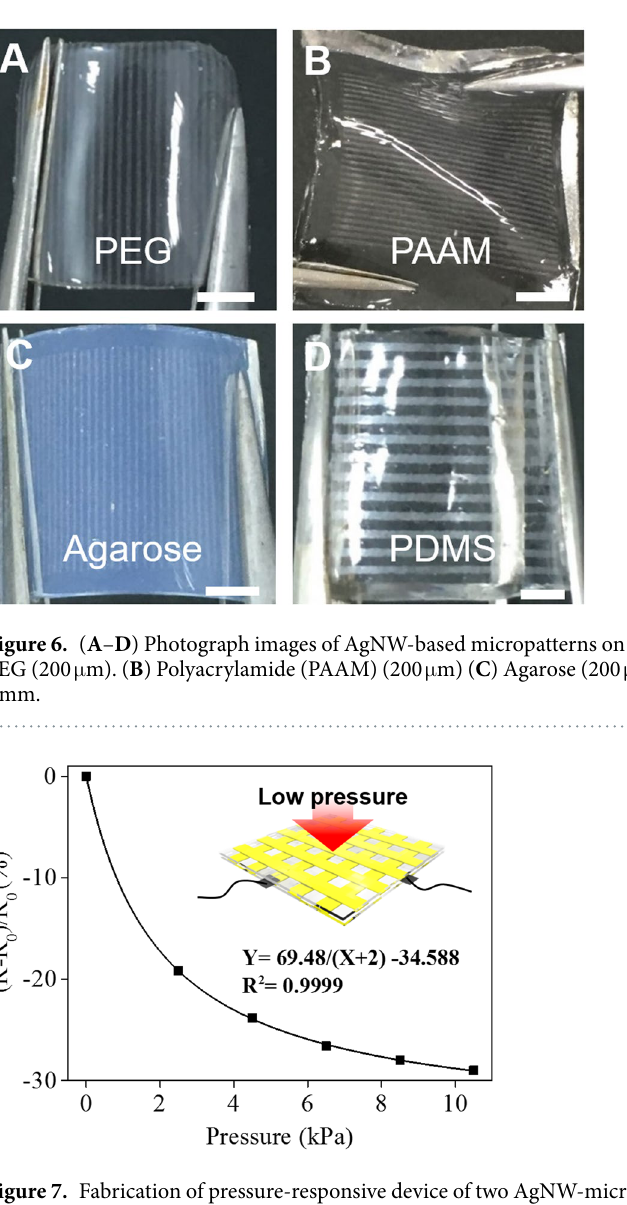
Figure 7. Fabrication of pressure-responsive device of two AgNW-microelectrodes on PEG hydrogel (1 mm on line pattern width) and tested the pressure response using hydrogel sandwich type. The inset shows that the experiments were conducted by applying pressure to the points where the line patterns with electrodes were engaged. The relative change of the resistance (RCR) graph of connected AgNW-microelectrode with different pressures (2.5, 4.5, 6.5, 8.5, and 10.5